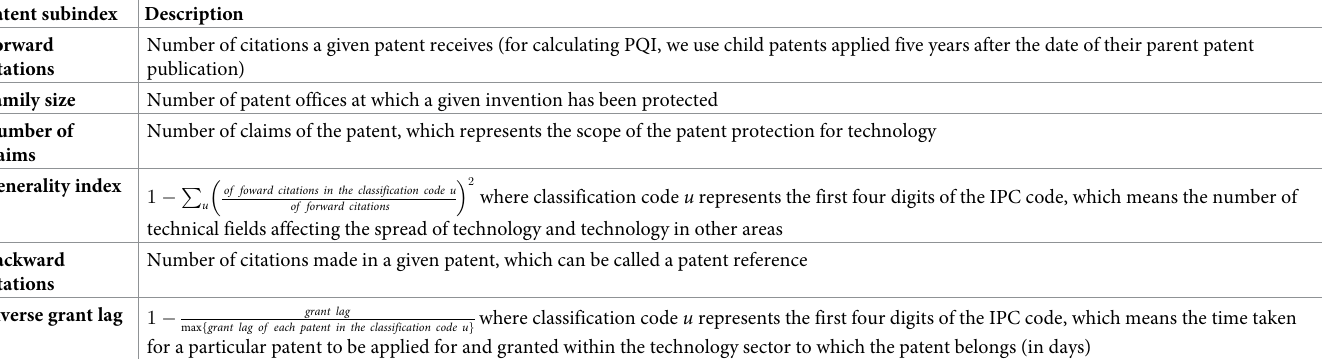
Table 1. Description of patent subindex for